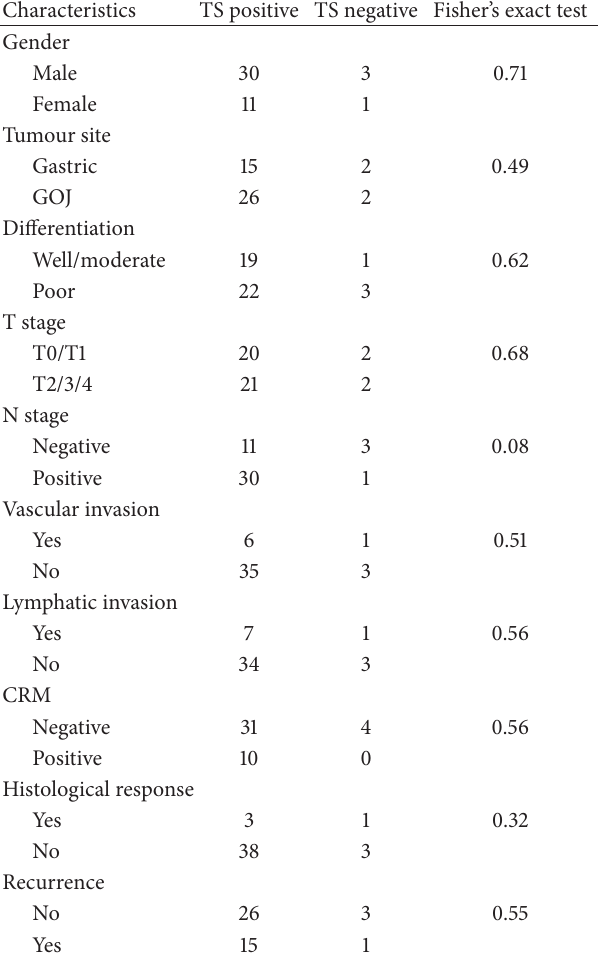
Table 2: Clinical and histological factor associations by Fisher’s Exact